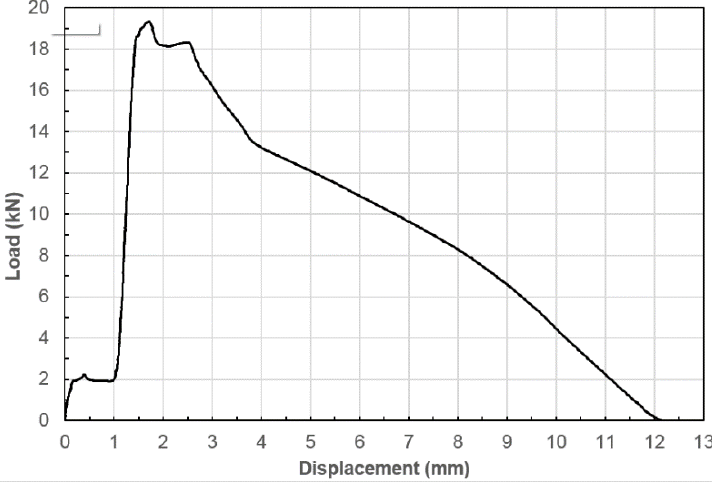
Figure 8. Experimental load-displacement curve.